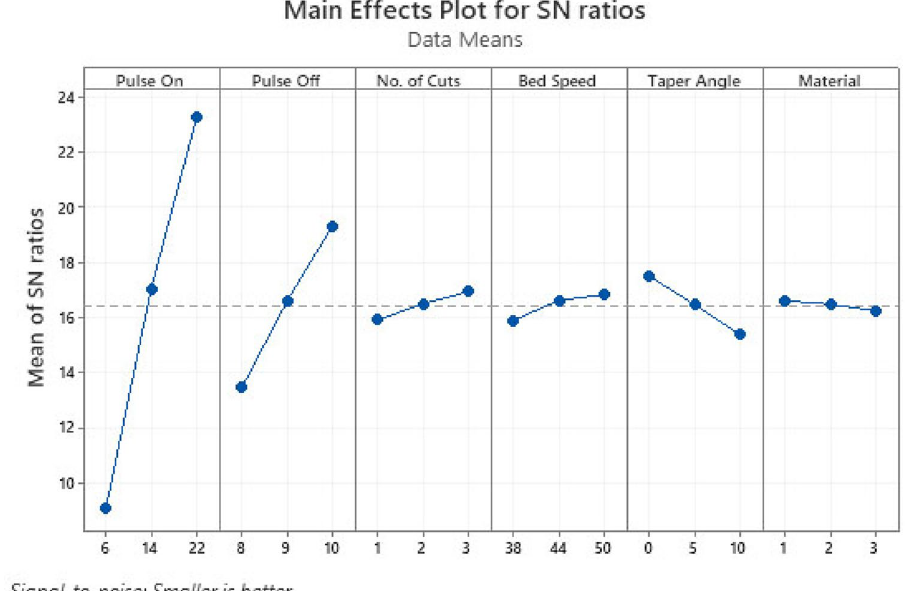
Fig. 8 Main effects plot for S/N ratios of ERR